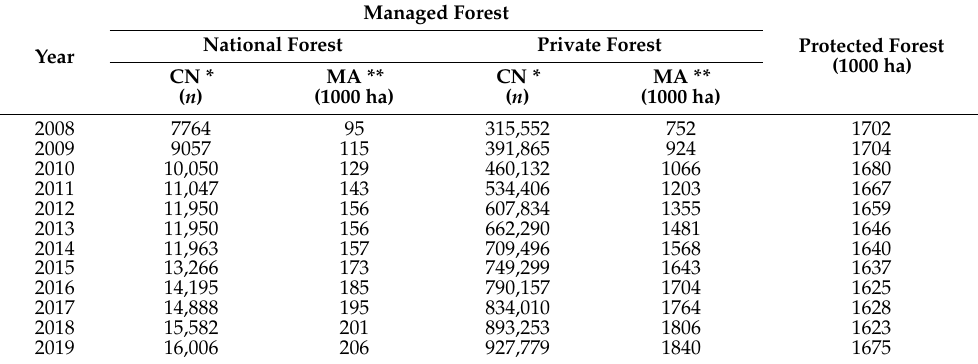
Table 2. Results of forest management area without considering redundant areas.